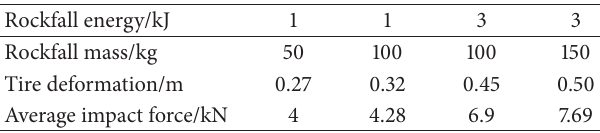
Table 8: The process contrast of different mass of rockfall in the same energy